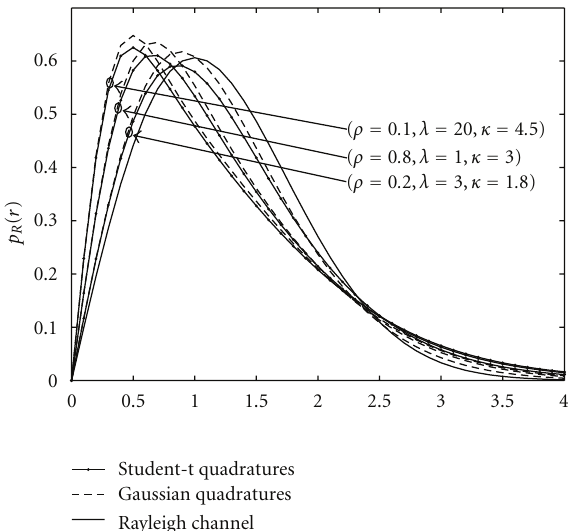
Figure 1: Envelope pdf of correlated bivariate Student-t and Gaussian quadratures for σ c = 1 and for several values of ( ρ , λ , κ ).